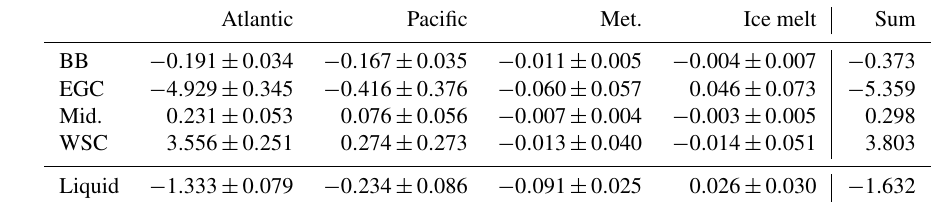
Table 9. Mean volume fluxes (Sv ± standard deviation) for the components of the Fram Strait flux (Belgica Bank, BB; East Greenland Current, EGC; mid-strait, Mid.; West Spitsbergen Current, WSC) from the four-end-member (4EM+) model. Positive values indicate fluxes into the Arctic. Atlantic Pacific Met.